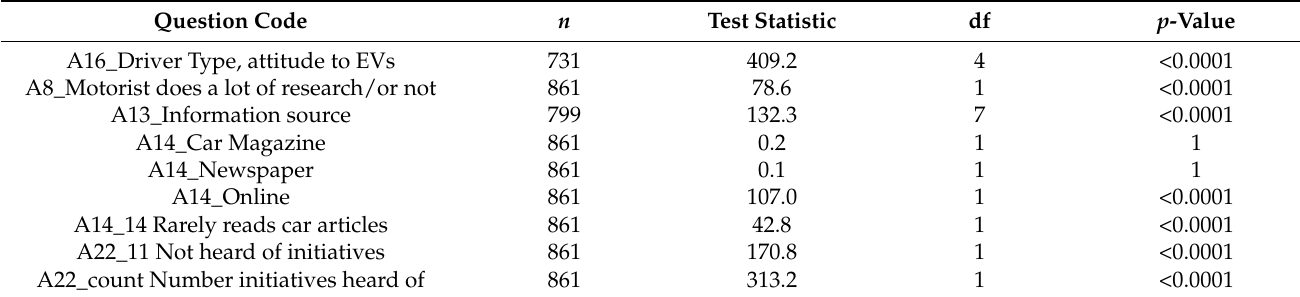
Table 5. Likelihood Ratio Tests Results: tests undertaken using ordinal logistic regression models with ‘Likelihood to purchase a BEV’ as the response variable. n is the number of samples left after filtering, df is the degrees of freedom and ‘p-value’ refers to the p -values that have been adjusted to account for multiple hypothesis testing using a Holm adjustment [45] to account for multiple hypothesis